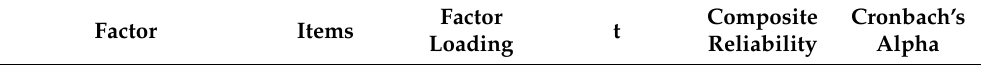
Table 2. The measurement